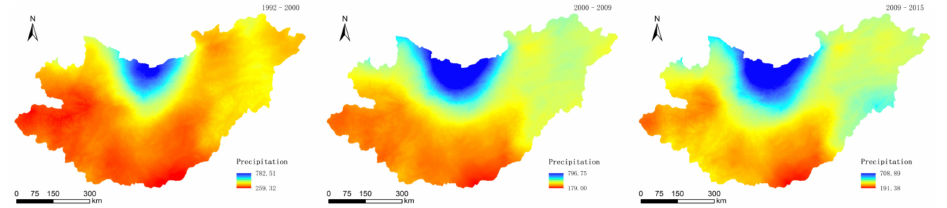
Figure 7. Precipitation in 1992–2000, 2000–2009, and 2009–2015.